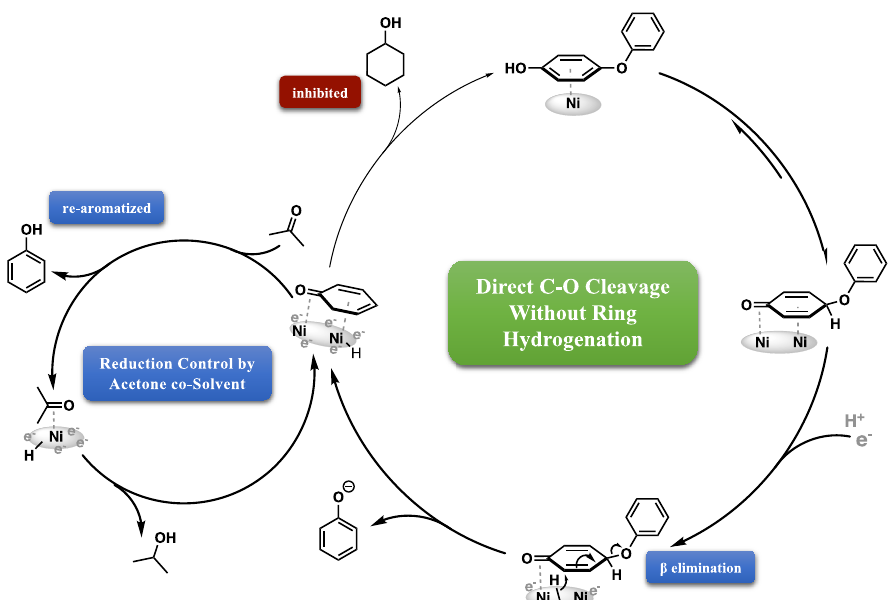
Fig. 8 Selective inhibition of aromatic ring reduction by acetone co-solvent. Schematic illustration of product selectivity control by the inclusion of acetone as a co-solvent during ECH of